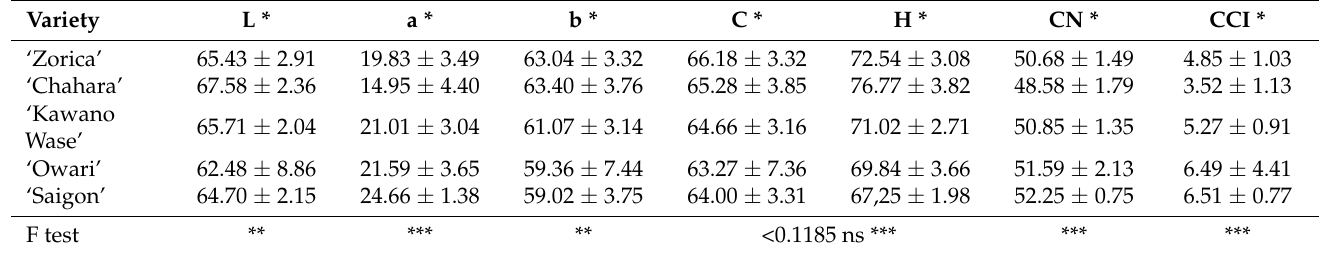
Table 2. Color parameters of mandarin fruit, citrus number (CN) and citrus color index (CCI).